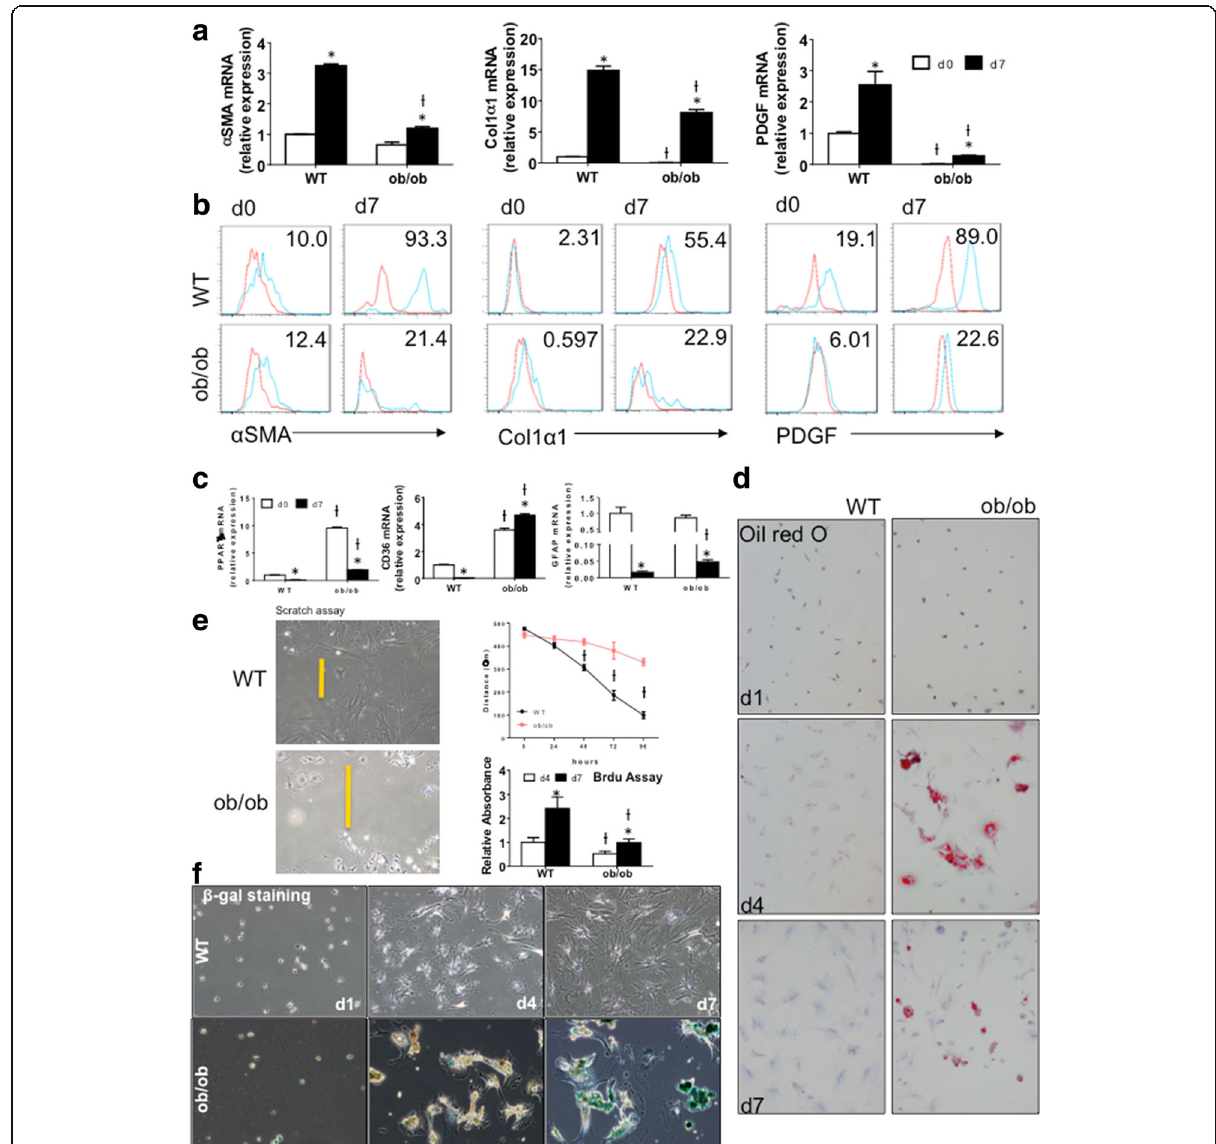
Fig. 2 Leptin Deficiency Changes HSC Phenotype. Primary HSCs isolated from WT and ob/ob mice were cultured on plastic dishes in serum- containing medium for 2 h (d0) or 7 days (d7). a qRT-PCR and ( b ) FACS analysis of MF genes ( α SMA, Col1 α 1, and PDGF), and ( c ) qRT-PCR analysis of quiescence genes (PPAR γ , CD36, and GFAP) in quiescent and myofibroblastic HSCs. Results were normalized to WT d0 cells. Ɨ p < 0.05 vs WT, * p < 0.05 vs d0. n = 3. Red lines indicate Isotype controls. d Lipid content of cultured HSC at indicated days was examined by Oil Red O staining. (original magnification, ×10) ( e ) Migration and proliferation of HSCs were measured by scratch assay and BrdU assay. Results were normalized